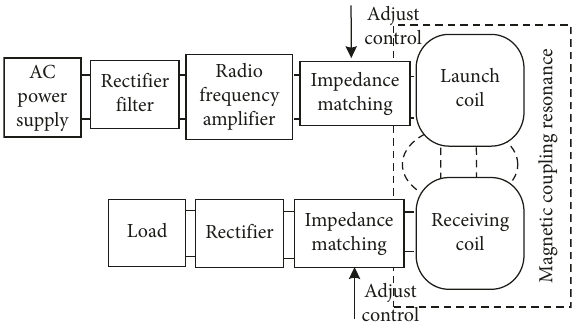
Figure 1: Block diagram of a medium-distance